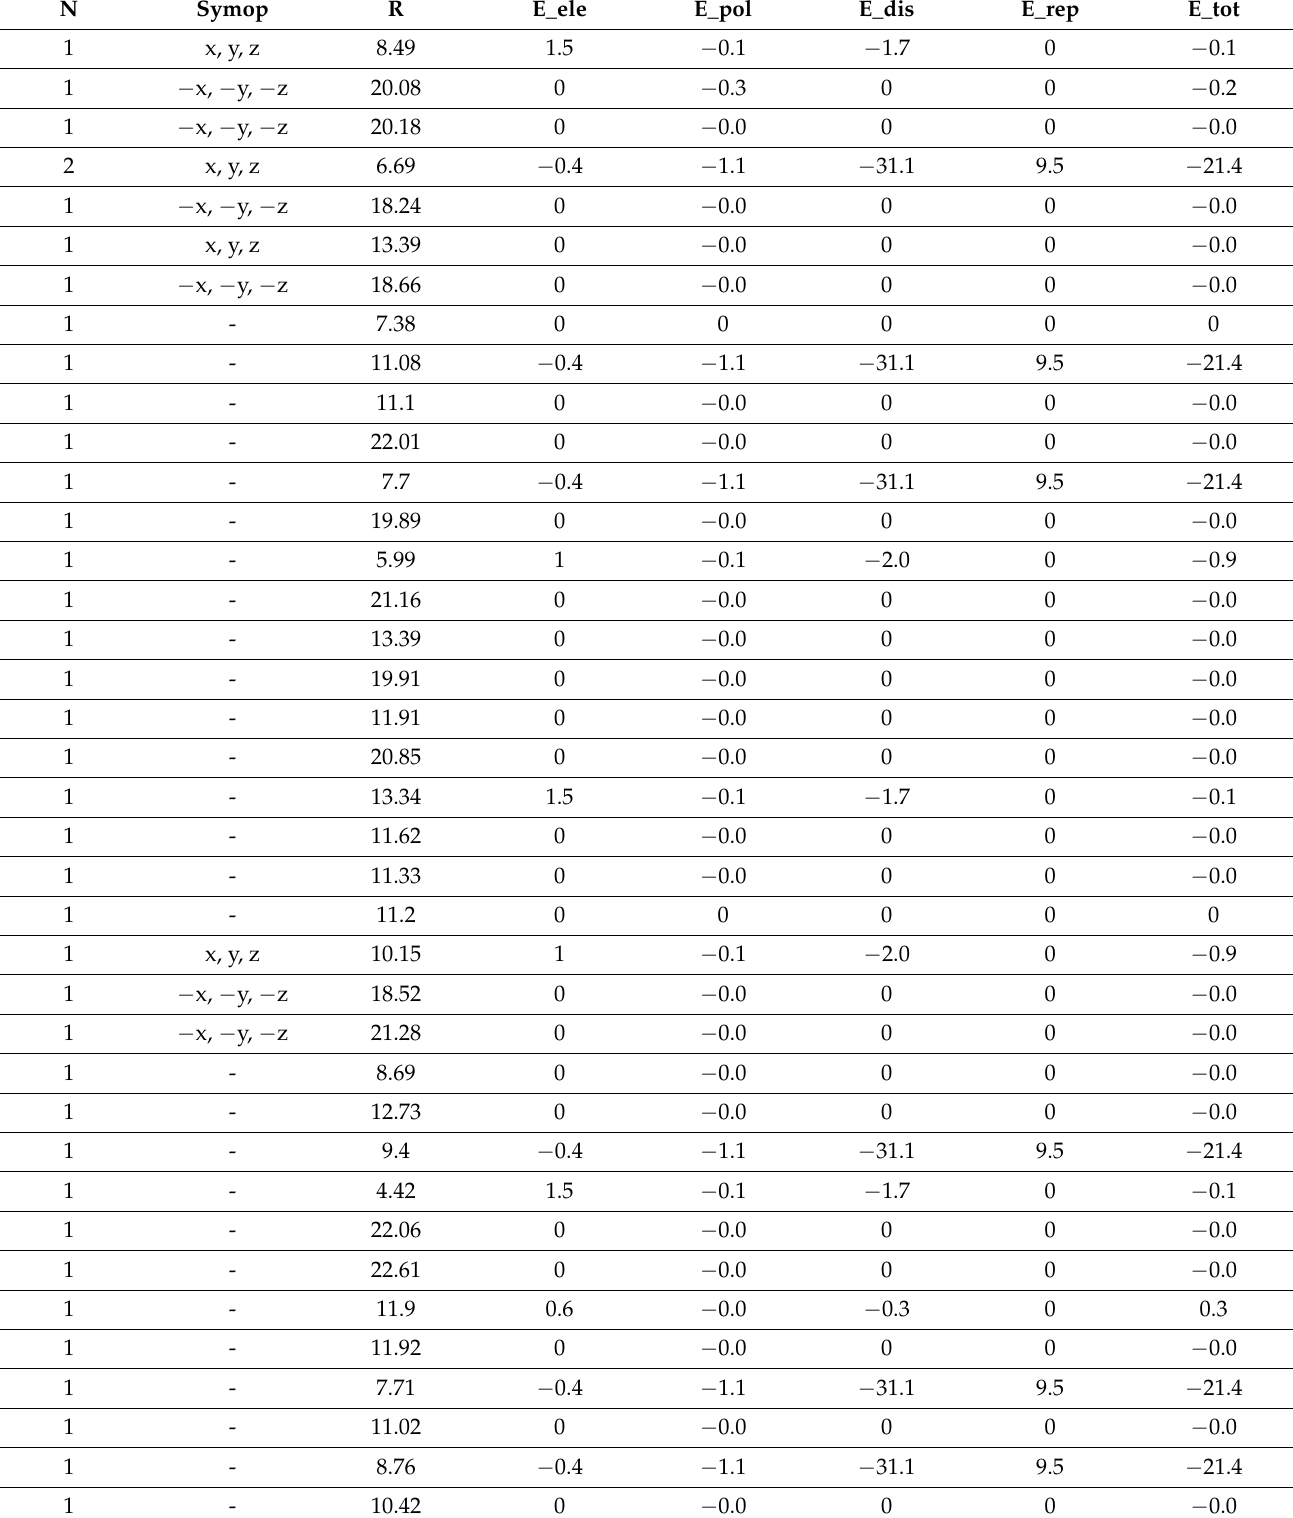
Table 7. Interaction energies of the 3C17 molecular pairs involved in energy calculation in kJ/mol. R is the distance between molecular centroids in Å, and N is the number of molecular pairs